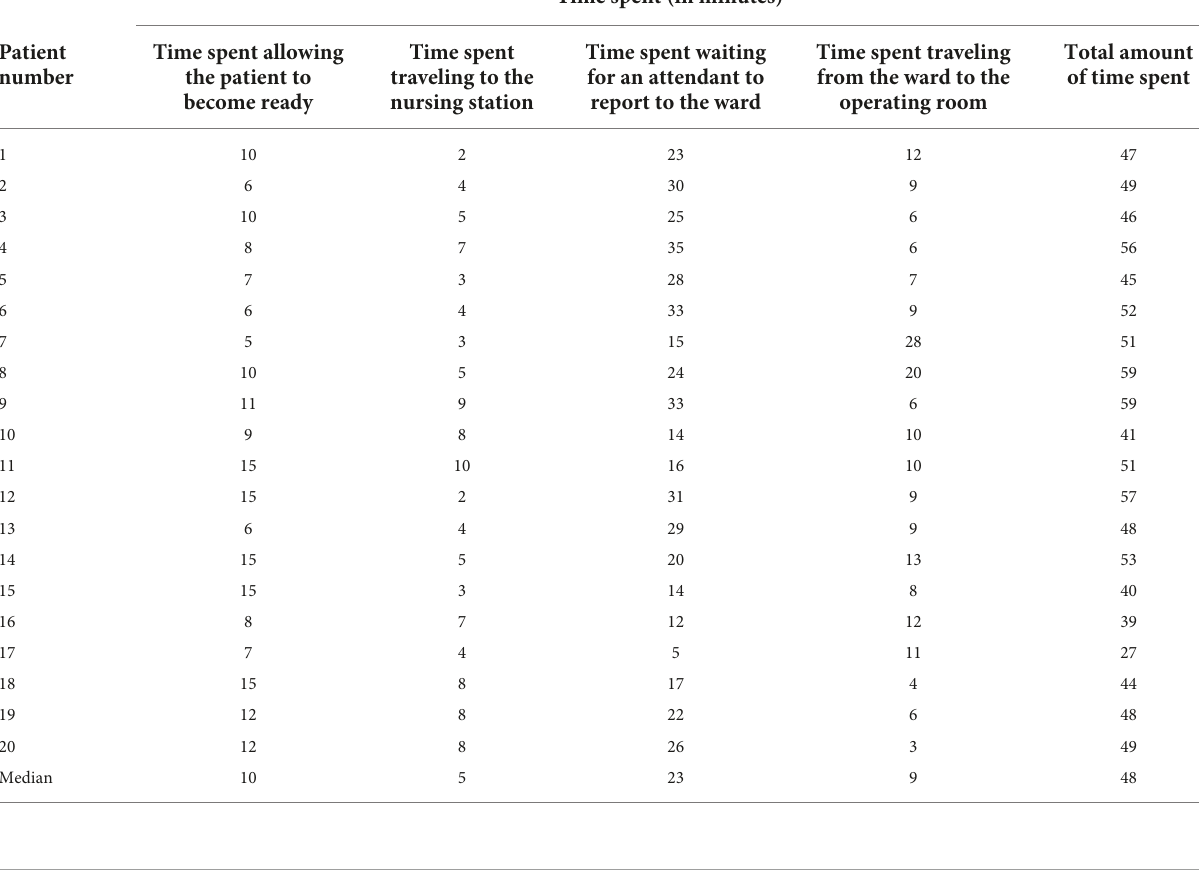
TABLE 2 The amount of time spent is calculated based on Table 1 .